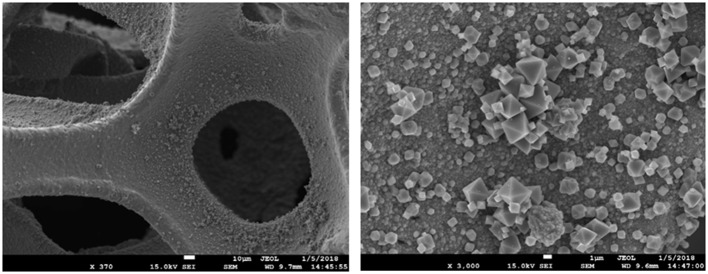
SEM images of Co1.